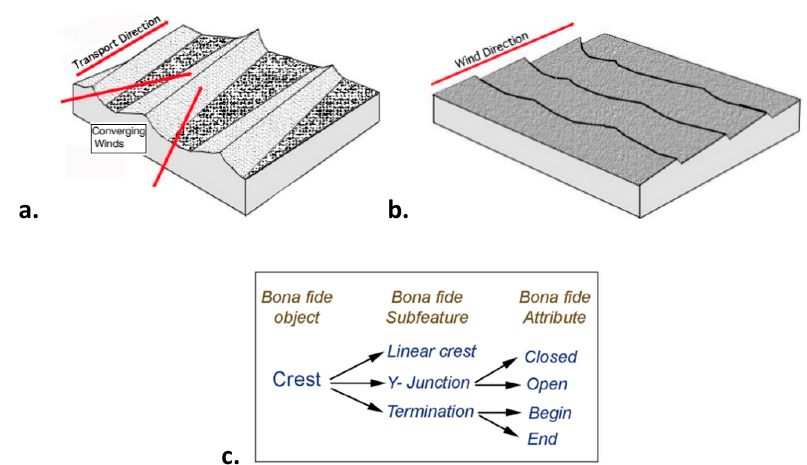
Figure 2. Dune types and wind direction relationships. ( a ) Linear dunes and their generating wind field. ( b ) Transverse dunes and their generating wind field. ( c ) Linear and transverse dune features and their attributes [20].